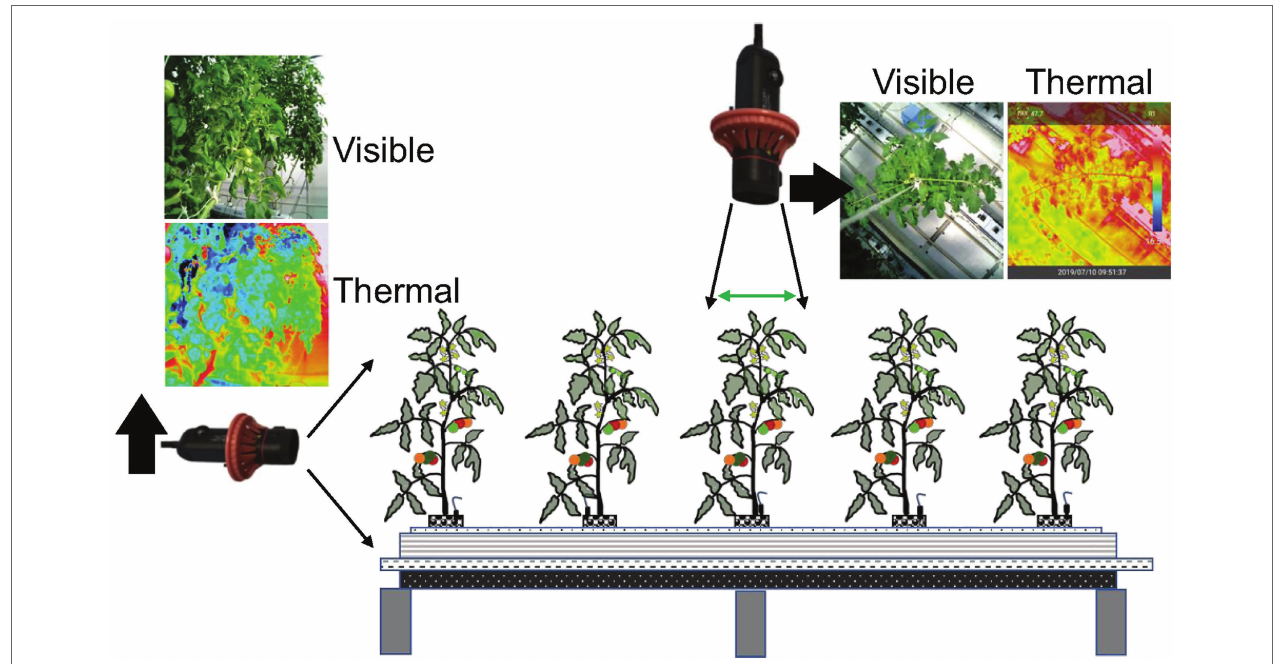
FIGURE 3 | Thermal image acquisition technique.